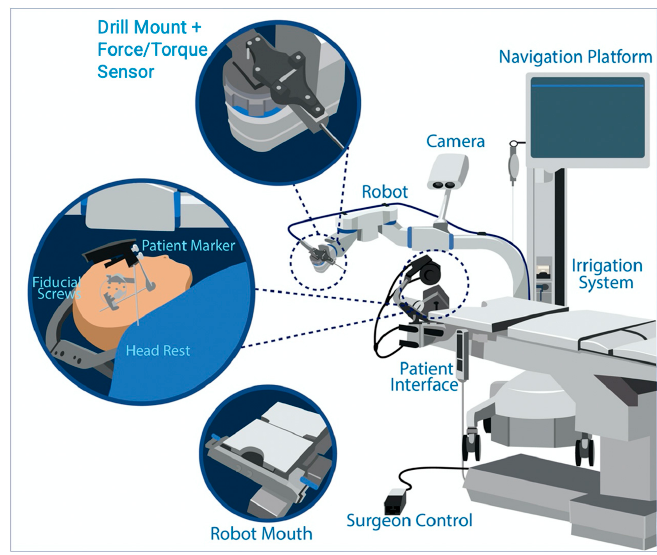
Figure 2. The HEARO system.